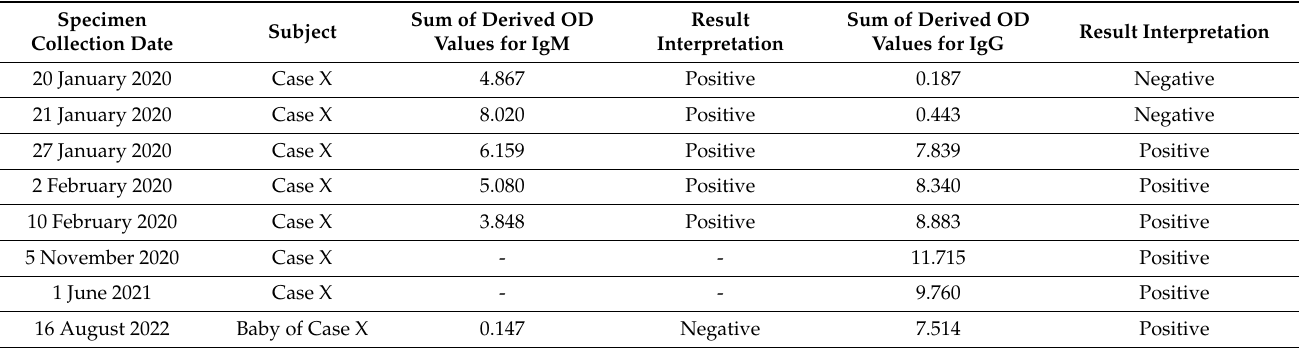
Table 2. Serum anti-Nipah IgM and IgG of “Case X” and her newborn